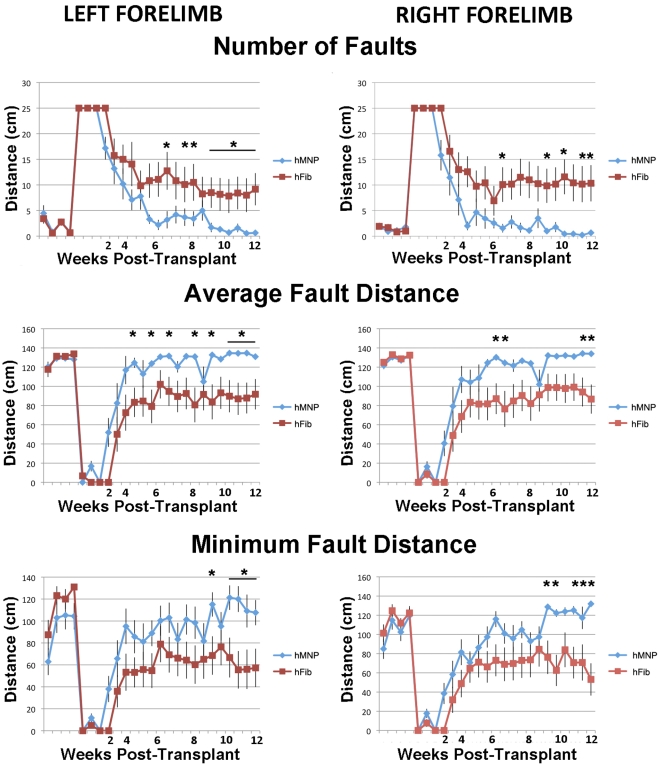
Transplanted hMNPs caused functional benefit.hMNP-transplanted animals performed significantly better than controls on the balance beam, demonstrating fewer foot faults, a greater average fault distance, and an earlier onset of functional recovery as determined by repeated measures ANOVA (p<0.05); * denotes Student's t-test p<0.05.